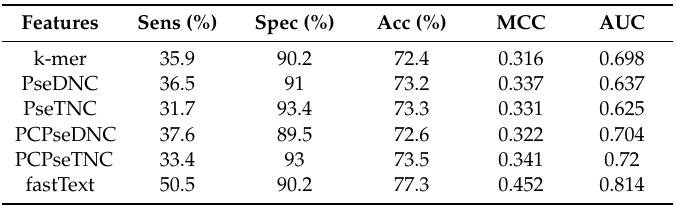
Table 3. Five-fold cross-validation performance in identifying essential genes using di ff erent